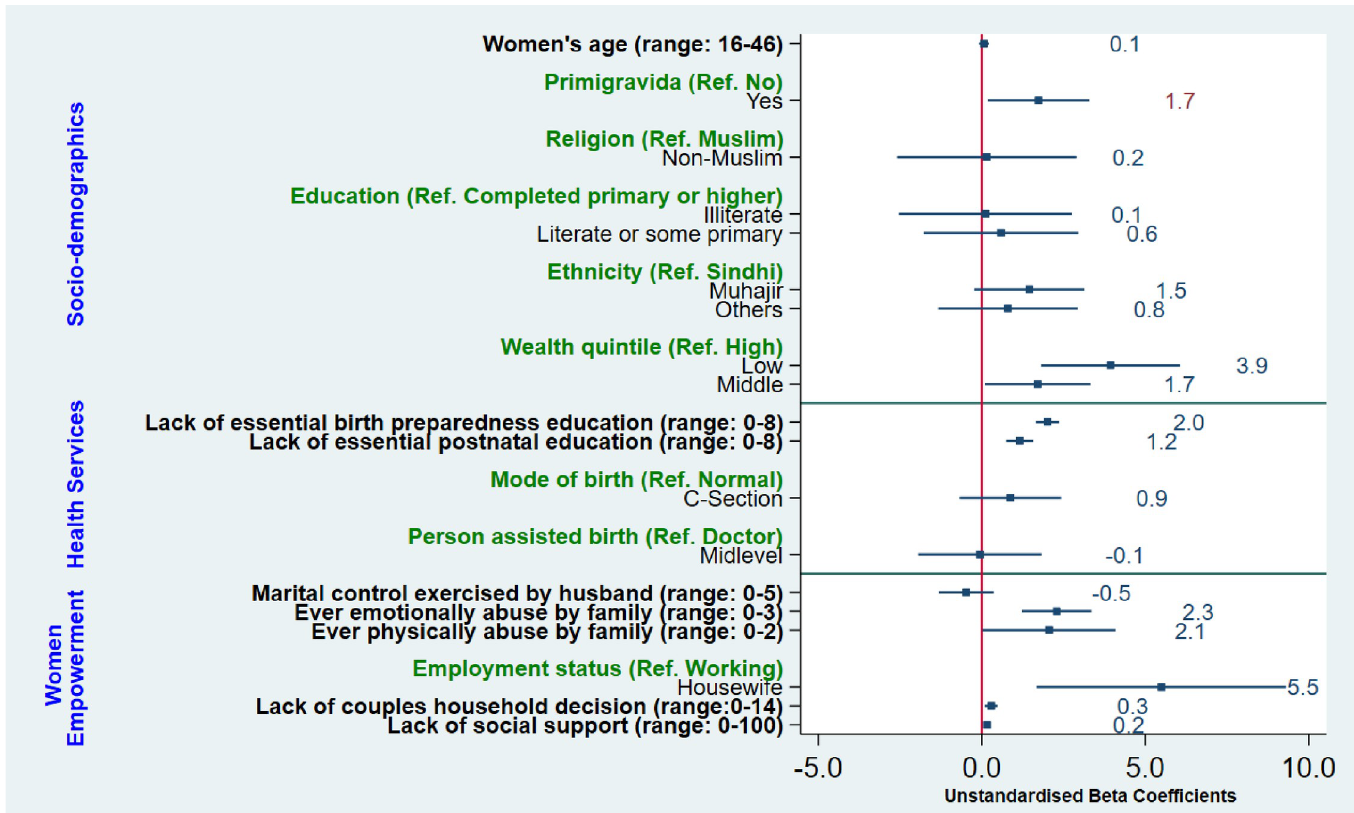
Fig 4. Factors underlying inequalities in women’s experiences of mistreatment during childbirth in facility-based settings.